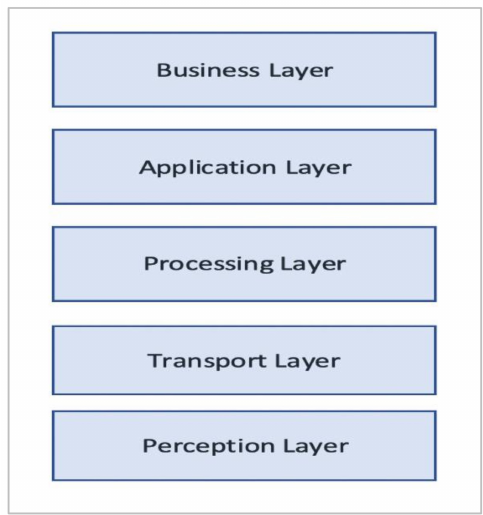
Figure 2. Five-layers IoT